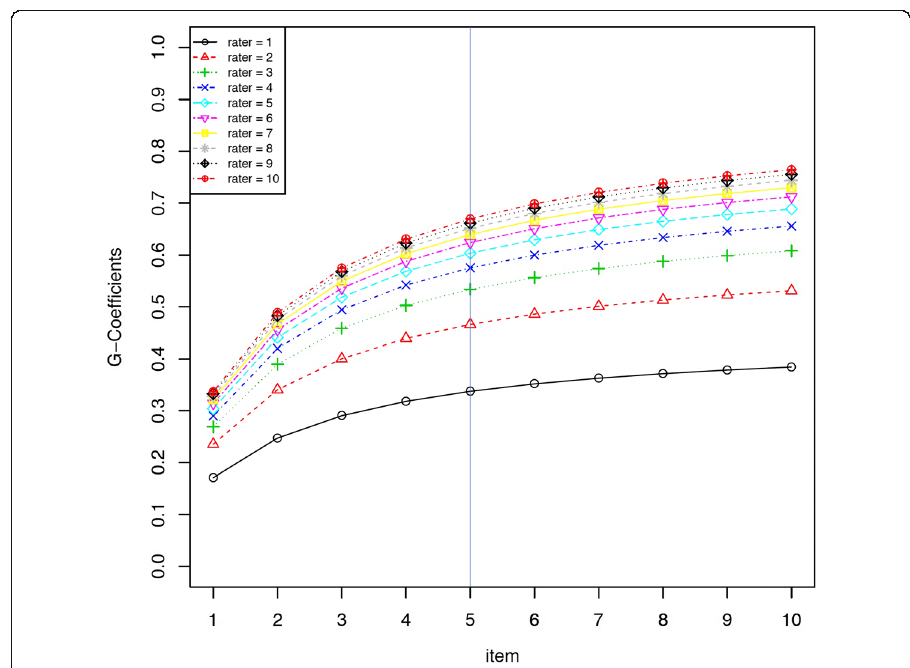
Fig. 3 D study simulation. The results changing the number of raters and dimensions are shown. The original number of raters and dimensions was six and five,